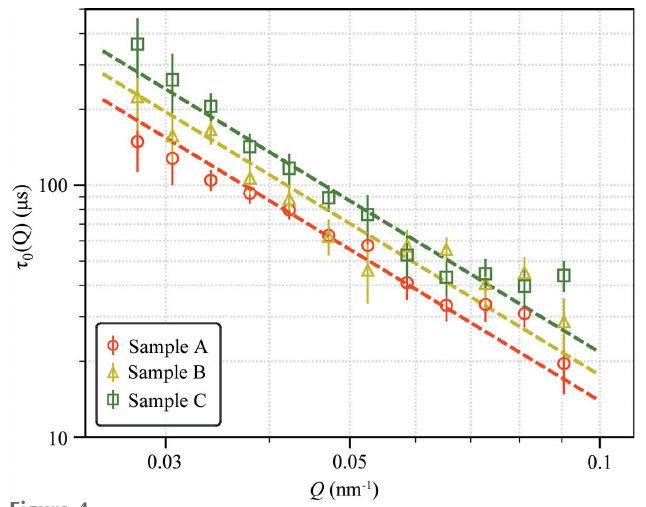
Figure 4 Comparison of CPMV diffusivity in samples A, B and C. The dashed lines represent the best fit to (cid:2) 0 ( Q ) = 1/( DQ 2 ) for each sample